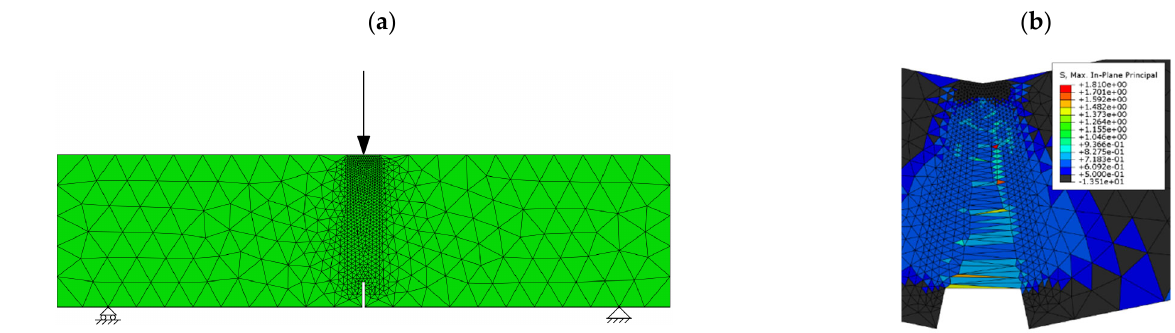
Figure 6. ( a ) Mesh refined along the crack path and boundary conditions, ( b ) maximum principal stress field in the damaged region of the model that used the linear constitutive law for 6 kg/m 3 fibre dosage with no crack tracking. Convergence is not reached.